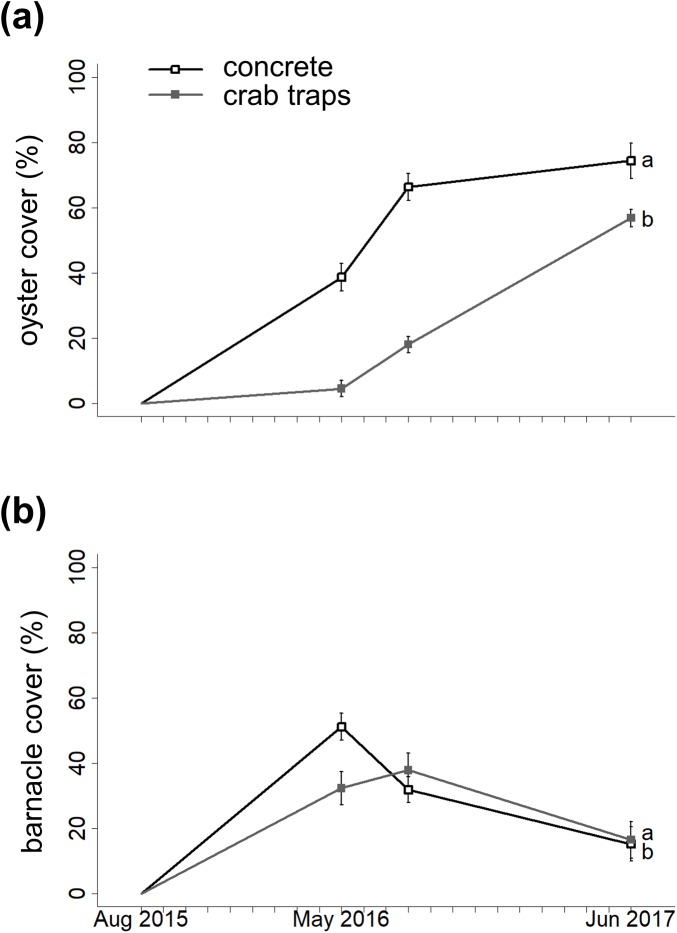
Changes in oyster cover and barnacle cover over time.Changes in oyster percent cover (A) and in barnacle percent cover (B) on concrete (open circles) and crab traps (solid squares) over the course of the experiment. Within each panel, different letters indicate a significant difference (α = 0.05).